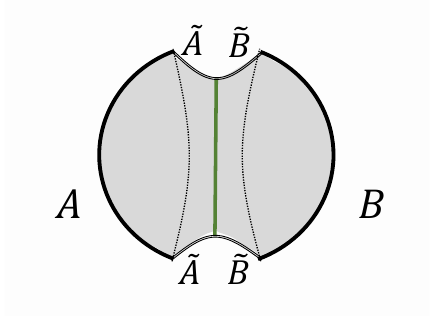
(cid:1828) Figure 3 . A derivation of E P = E W based on the tensor network description of AdS